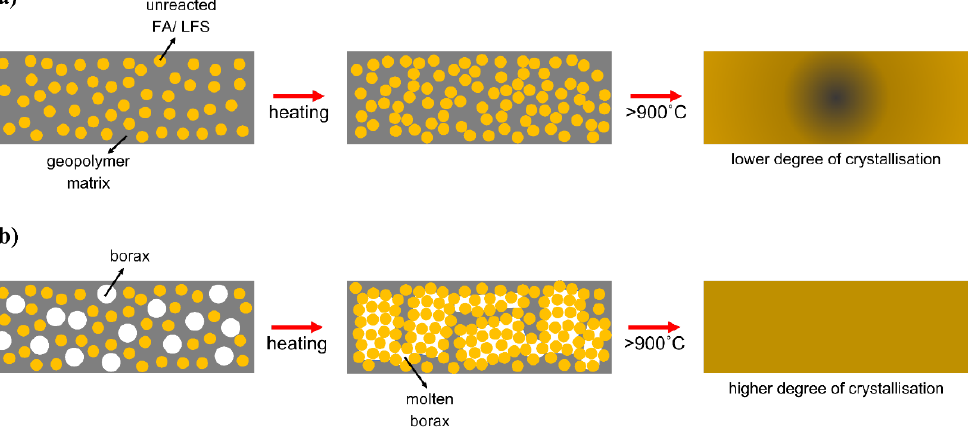
Figure 9. Schematic diagram of thermal transformation of thin geopolymers ( a ) without and ( b ) with borax decahydrate addition.